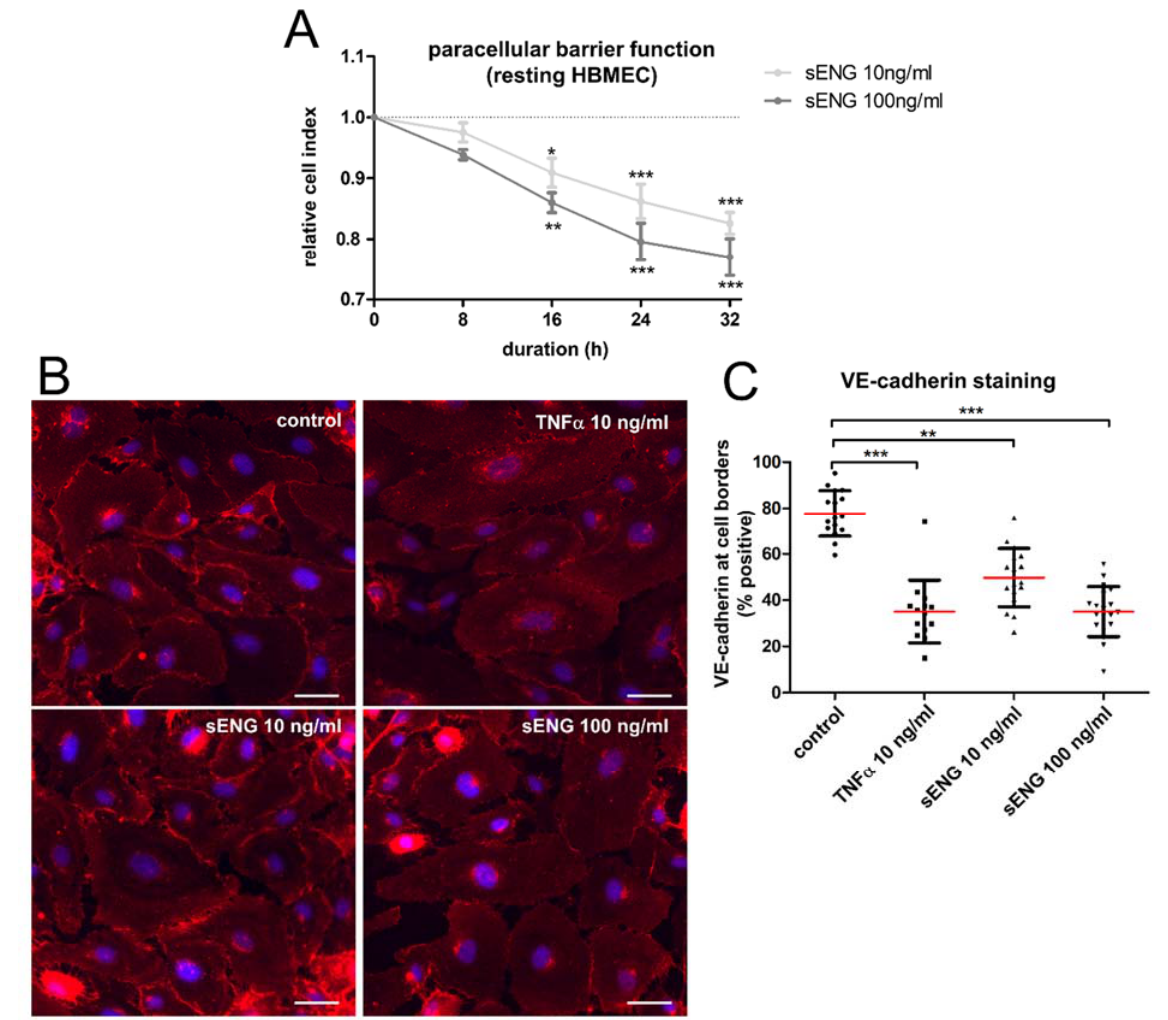
Figure 4. Soluble ENG impairs resting endothelial monolayer integrity causing increased paracellular permeability and the downregulation of VE ‐ cadherin. ( A ) Label ‐ free assessment of transendothelial resistance of HBMEC in an impedance ‐ based xCELLigence DP system. Confluent monolayers were stimulated with the indicated concentrations of sENG. Data represent the changes relative to untreated cells of five independent experiments. ( B ) Immunocytochemistry of resting HBMEC visualizing VE ‐ cadherin after stimulation, as indicated. Representative of three experiments. Scale bar = 50 μ m. ( C ) Quantification of VE ‐ cadherin staining by blotting the ratio of the cell borders with positive staining to the cell circumference. Statistical testing for normal distribution by the D’Agostino – Pearson omnibus K2 test, followed by one ‐ way ANOVA and the Bonferroni post ‐ hoc test. (* p < 0.05; ** p < 0.01; *** p < 0.001).